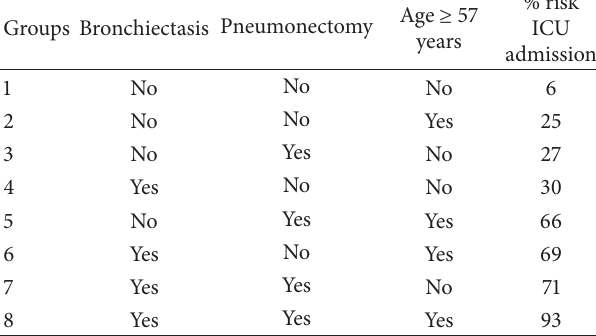
Table 4: Risk of effective use of ICU after lung resection considering the presence or absence of identified risk